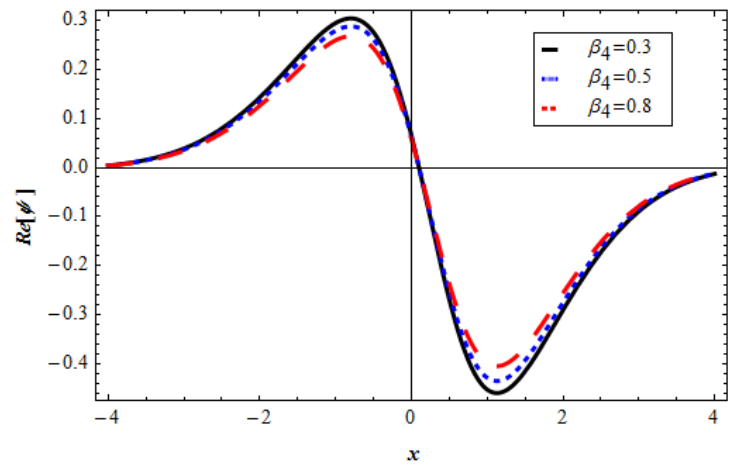
Figure 18. Change of solution (14) with z , t , β 3 for c = 0.5, v = 0.7, β 1 = 0.1, β 2 = 1, β 4 = 0.2.